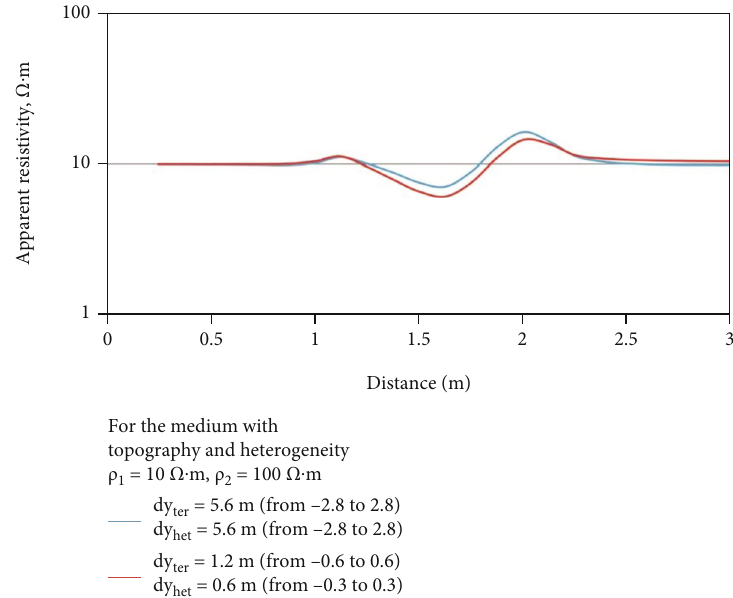
= 1 : 2 m , dy = ter het